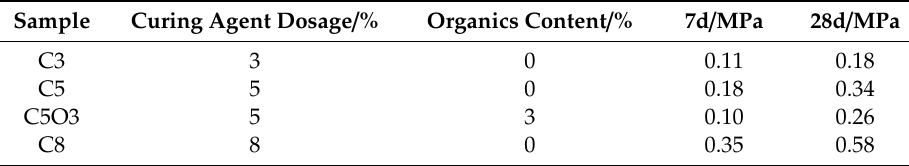
Table 4. Strength of river sediment solidified with di ff erent